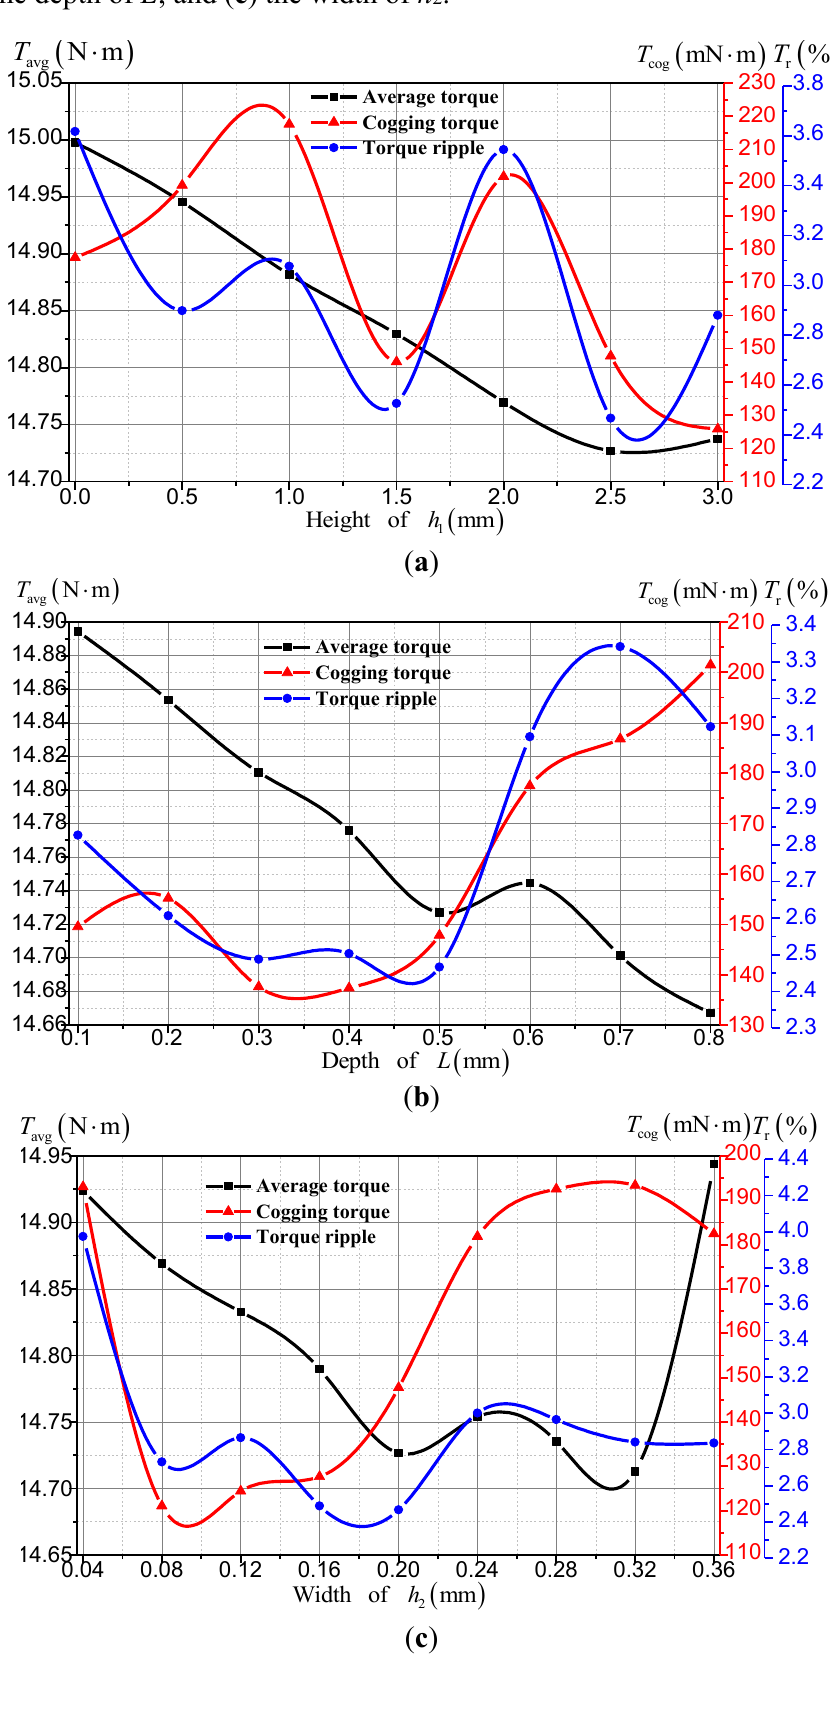
Figure 12. Average torques, torque ripples, cogging torques according to: ( a ) the height of h 1 ; ( b ) the depth of L ; and ( c ) the width of h 2